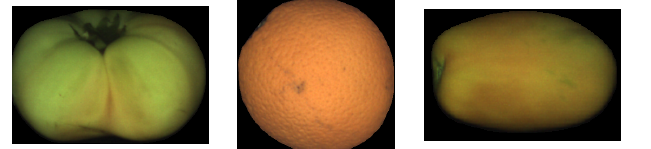
Figure 6. Samples of different fruit shapes. Left : oblate; Center : spherical; Right :